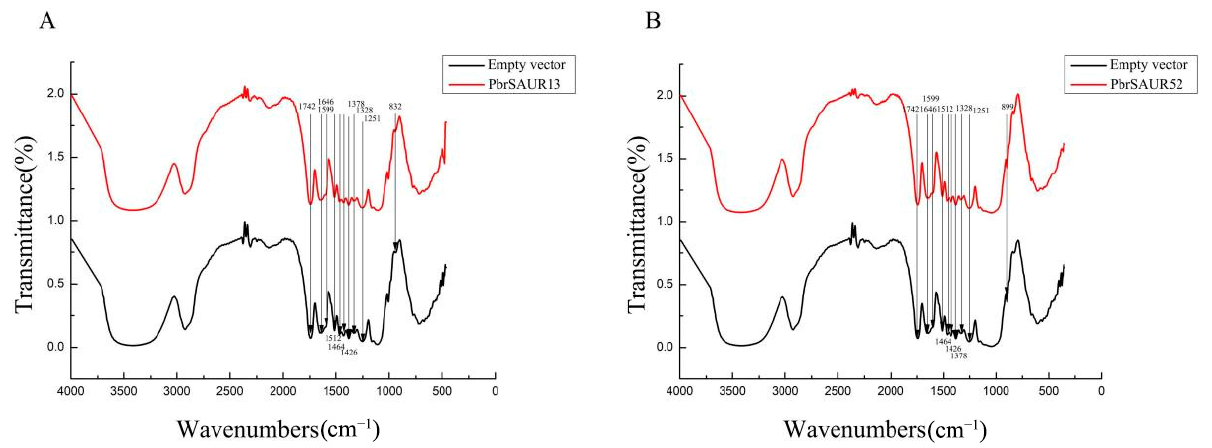
Figure 11. Infrared spectrum of lignin in Pear Fruit overexpressed by PbrSAUR13 ( A ) and PbrSAUR52 ( B ). Table 2. Infrared spectrum characteristic peaks and attribution of lignin in PbrSAUR13,52 overex- pressed pear fruit.